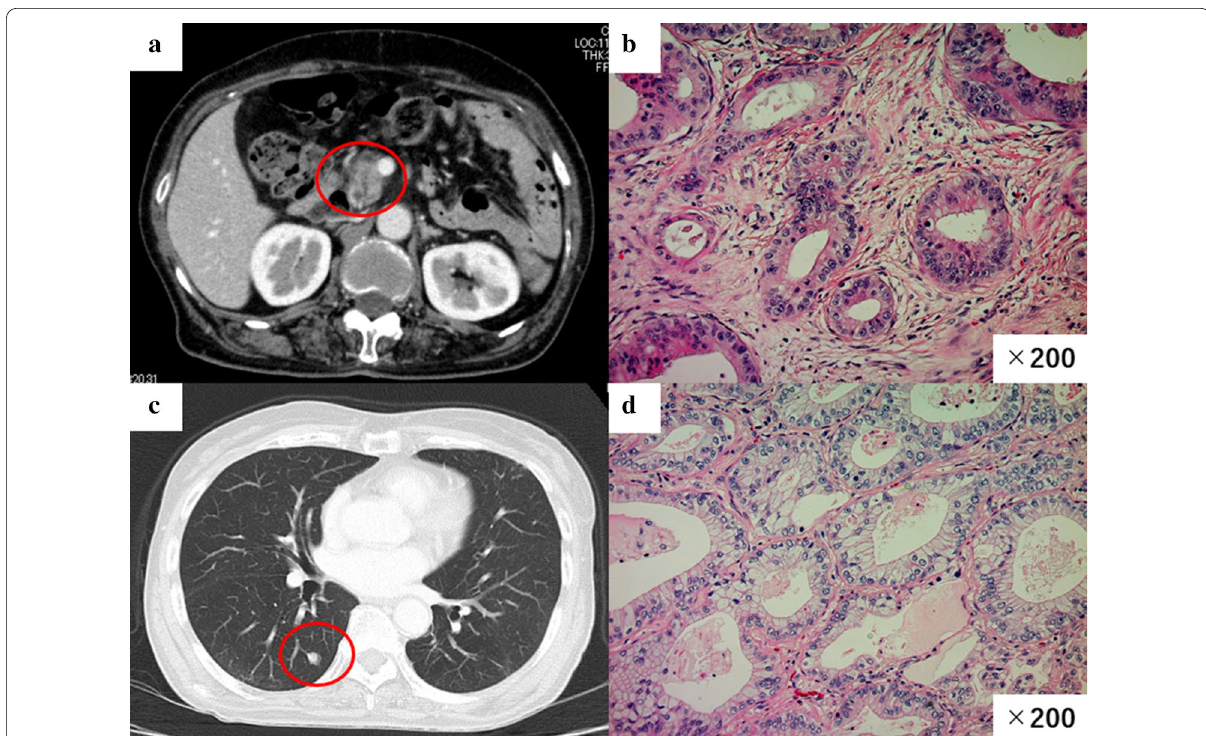
Fig. 3 a CT image showing a 2.0 cm hypovascular tumor in the pancreatic head. b Photomicrograph showing cancer cells with abundant fibrosis arranged in tubular structures (HE staining). Original magnification: 200. c CT image showing a nodule in the right lung (S6). d Photomicrograph × showing a tumor that was diagnosed as metastatic pancreatic cancer (HE staining). Original magnification: ×